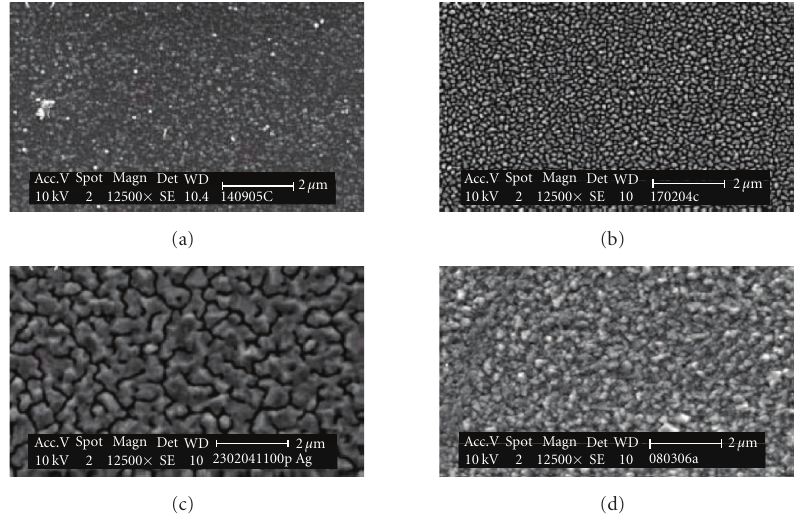
Figure 2: SEM images of (a) Ag 2 passes, (b) Ag 30 passes, (c) Ag 100 passes, (d) electroplate Ag.